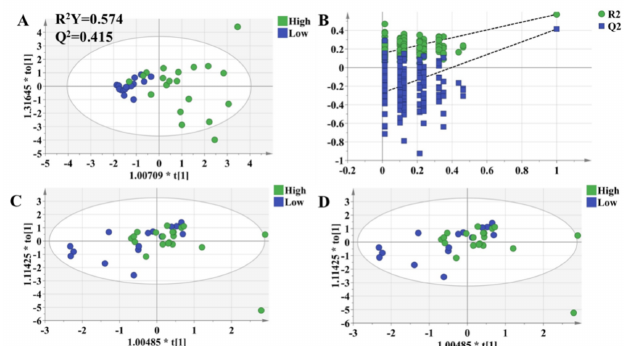
Figure 6. OPLS-DA model to discriminate subgroups based on the selected variables. Each dot represents an individual. Green dots indicate individuals in the high-response group, while blue dots mean individuals in the low-response group. ( A ) The OPLS-DA model of individuals who were 1 week after transplantation. ( B ) Permutation tests of the model in Figure 6A, which were performed with 200 iterations, indicated that the predictive models were not overfitting. ( C ) The OPLS-DA model of the individuals who were 1 month after transplantation. ( D ) The OPLS-DA model of individuals who were 3 months after